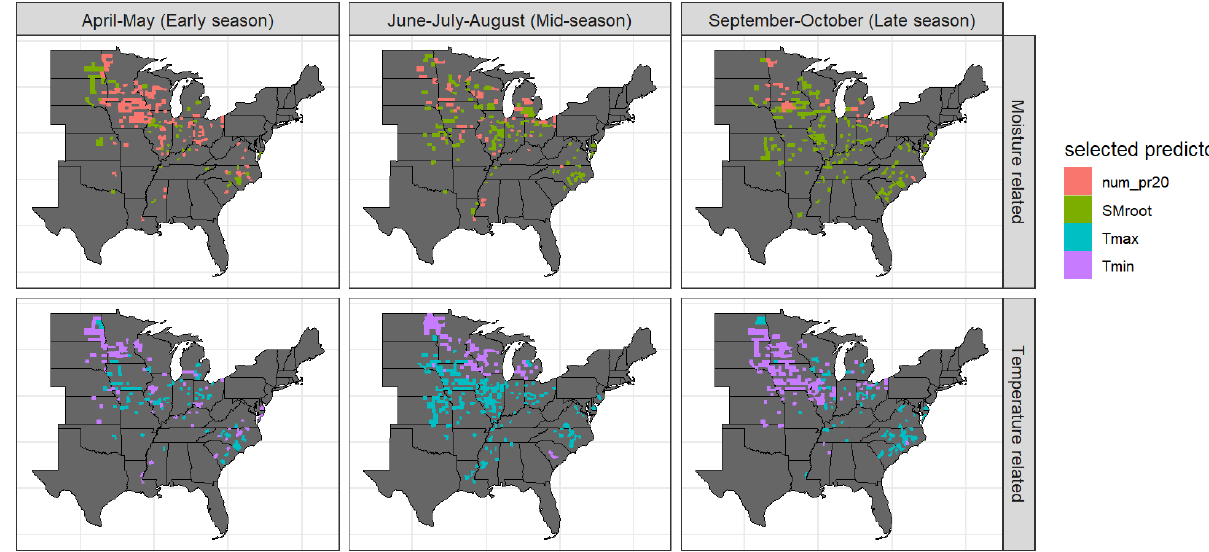
Figure A1. Selected predictors per county based on the full dataset.